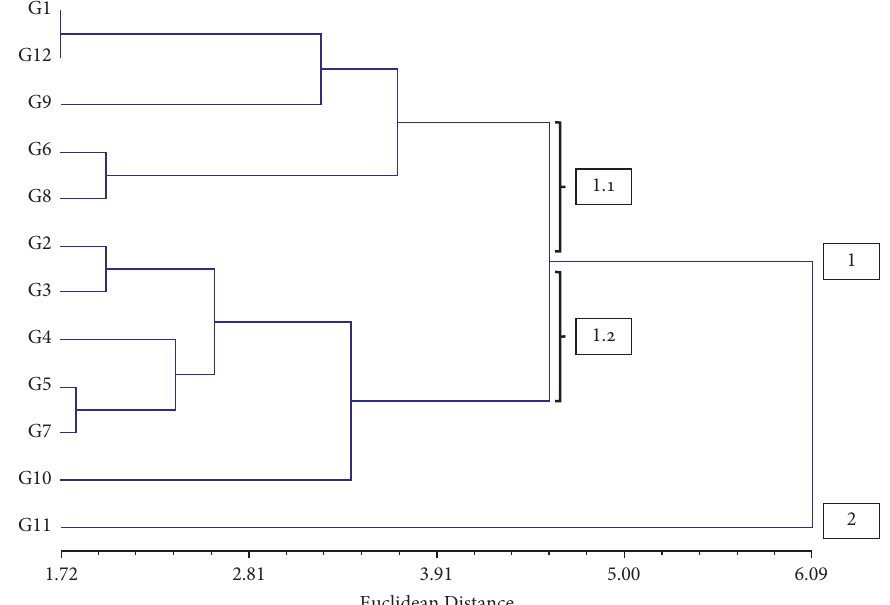
Figure 6: Dendrogram for nine genotypes of PFSP and three commercial varieties as checks based on agronomic traits in Jatinangor Sumedang.